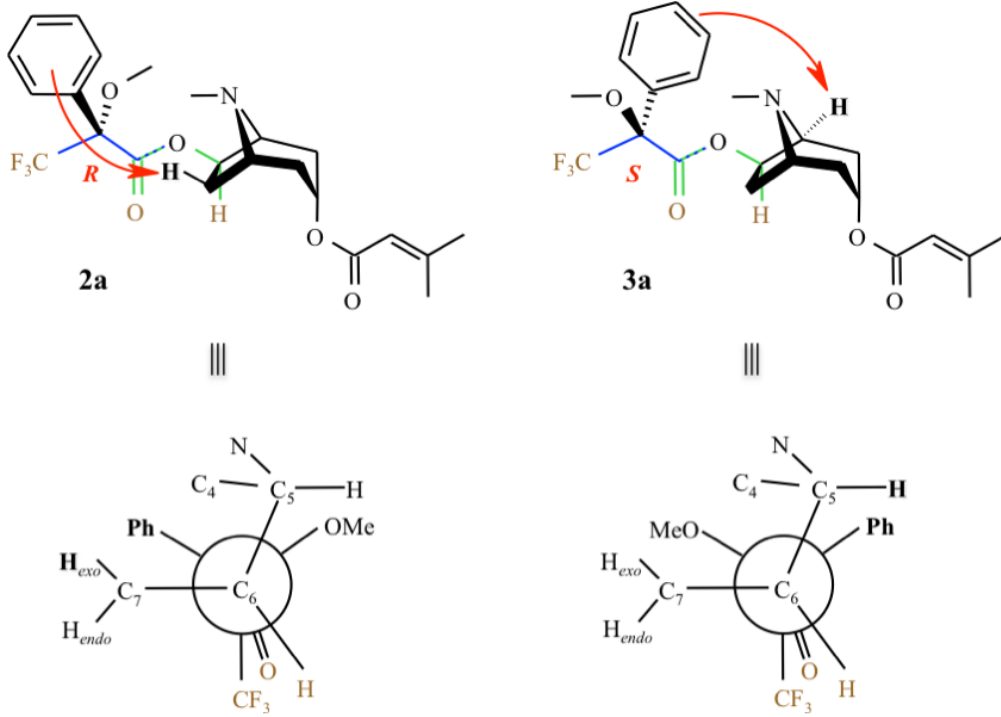
Figure 3. The anisotropy generated by the MTPA’s aromatic ring depends on the configuration and conformation of the auxiliary reagent. To have a significant effect, the phenyl group must produce a direct influence and thus be in a rigid conformation. Earlier experimental [5,27–29,31] and theoretical [32] studies showed that the ester group is oriented anti -periplanar relative to the CF group, and syn -periplanar with respect to the 3 proton of the chiral carbon. The ester, the CF groups as well as the C-H bond of the chiral 3 carbon are coplanar which makes this part of the molecule